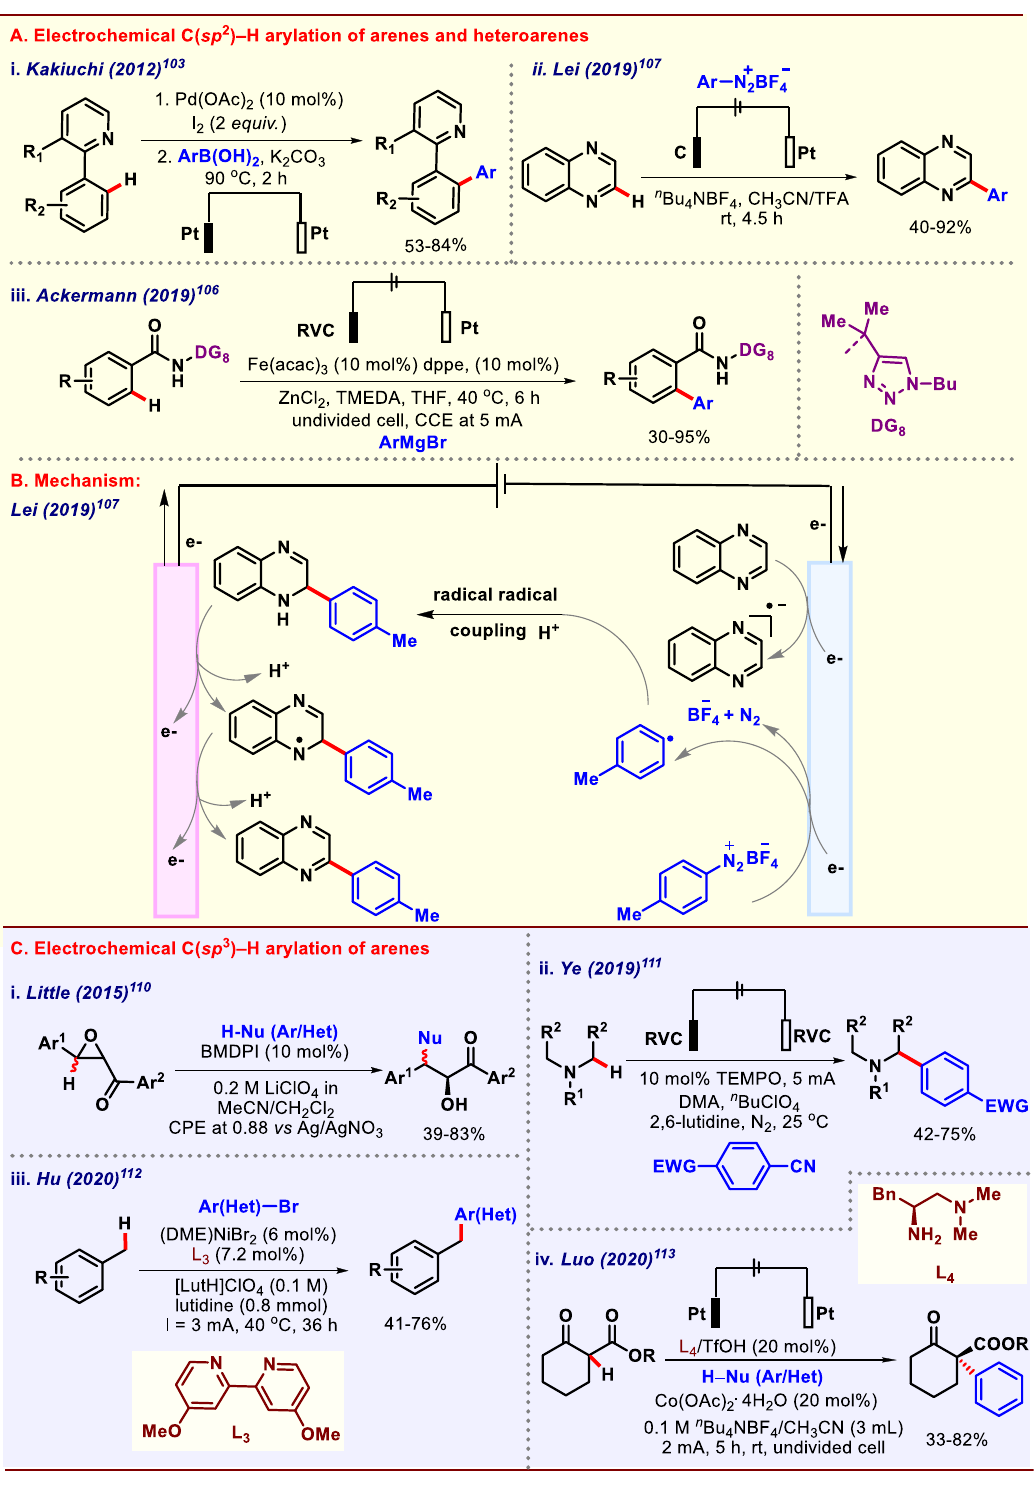
Fig. 8 Electrochemical C – H arylation. A Electrochemical C( sp 2 ) – H arylation of arenes. B Mechanism of electrochemical C – H arylation of arenes. C Electrochemical C( sp 3 ) – H arylation of